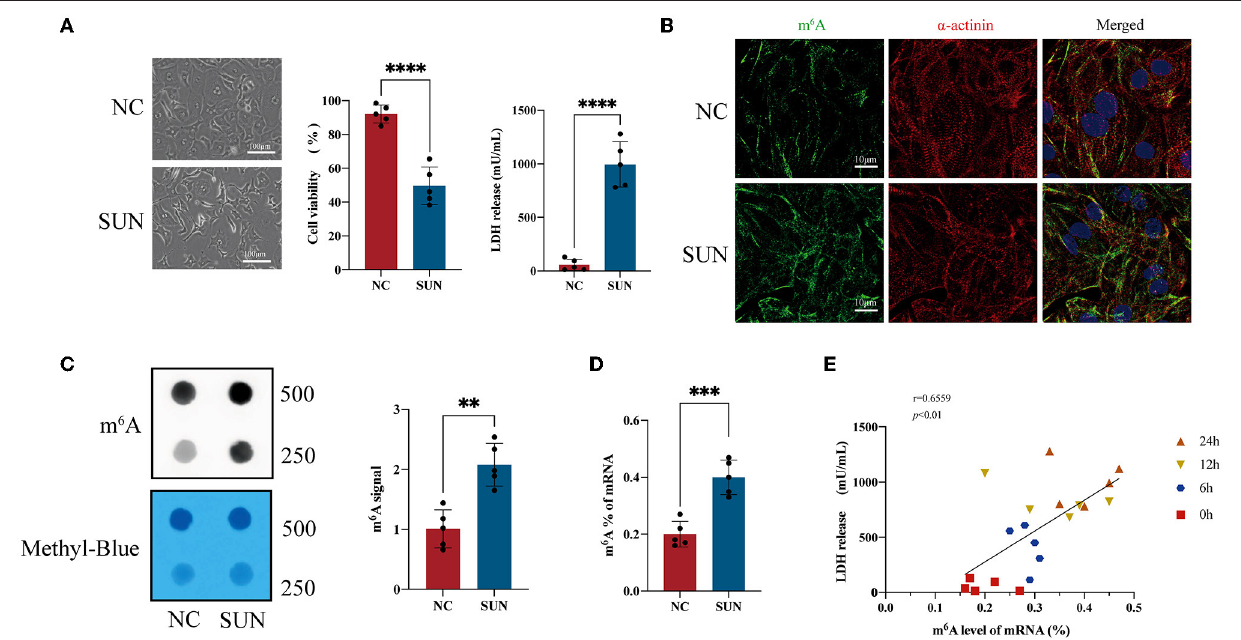
FIGURE 1 | The global N 6 -methyladenosine (m 6 A) methylation level of sunitinib (SUN)-treated human-induced pluripotent stem cell-derived cardiomyocytes (hiPSC-CMs). (A) Representative images after SUN treatment for 24h and measurement of lactate dehydrogenase (LDH) release level and cell viability are shown ( n = 5). (B) The levels of m 6 A methylation in the normal control (NC) and SUN groups detected by m 6 A antibody-based immunofluorescence. Red denotes α -actinin, green denotes m 6 A, and blue denotes 4 ′ ,6-diamidino-2-phenylindole (DAPI). (C) The m 6 A level of total RNA of hiPSC-CMs is indicated by an m 6 A dot blot. Corresponding RNAs were loaded equally by a 2-fold serial dilution with 500 ng and 250 ng of methylene blue staining served as a loading control. (D) The RNA m 6 A level detected by the colorimetric method. (E) The m 6 A level of messenger RNA (mRNA) and the level of LDH release exhibit a time-dependent gradual increase after SUN treatment and the two indicators are positively correlated. “**” indicates p < 0.01, “***” indicates p < 0.001, and “****” indicates p <